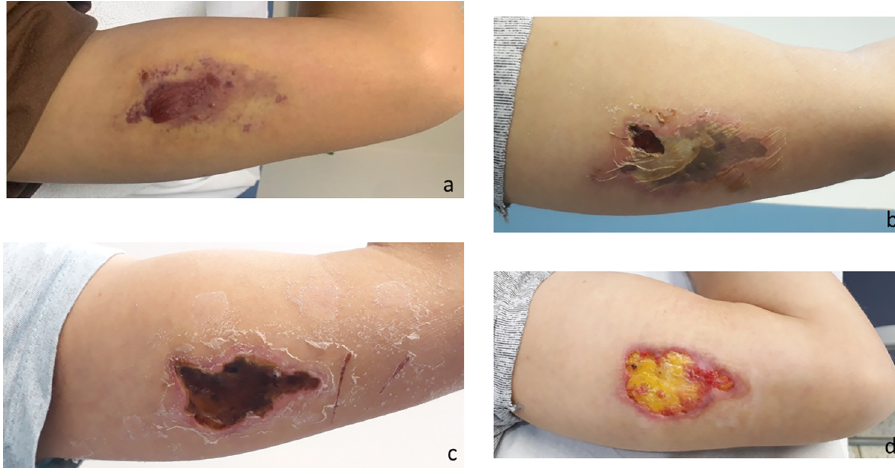
Fig 6. Evolution of the cutaneous lesion after a Loxosceles sp. bite in a patient with cutaneous-hemolytic loxoscelism. (a) 8 days after the bite; (b) 17 days after the bite; (c) 24 days after the bite; (d) 52 days after the bite.